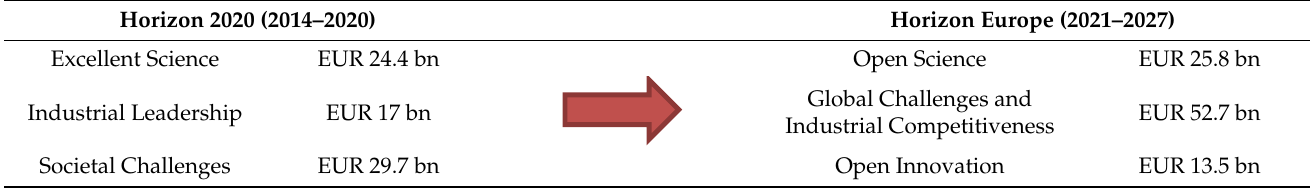
Table 2. Comparison between Horizon 2020 vs. Horizon Europe.